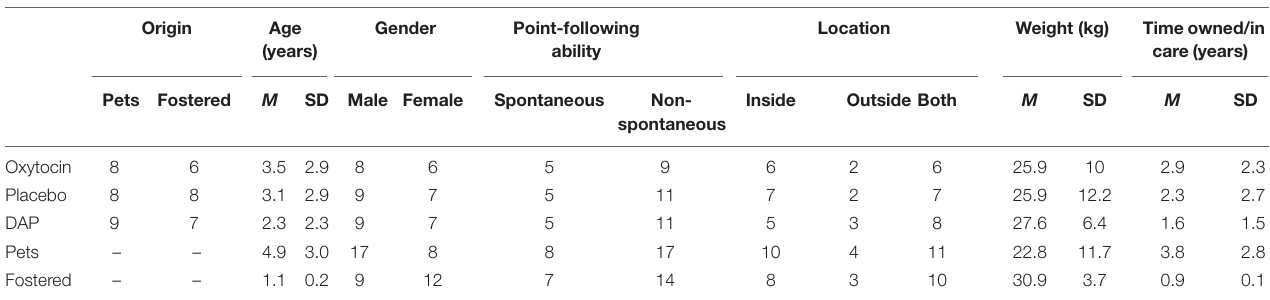
TABLE 1 | Study population descriptive data separated by treatment allocation group and